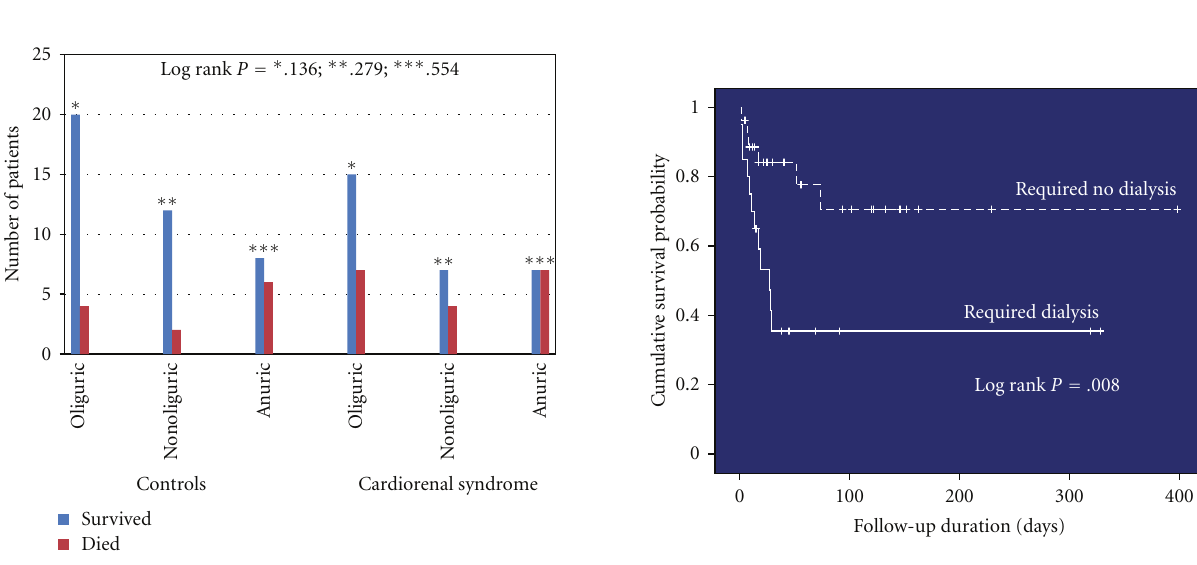
Figure 5: Kaplan-Meier survival curves for dialysis-requiring and non-dialysis requiring cardiorenal syndrome patients. Dialysis- requiring-cardiorenal syndrome had significantly lower survival rate compared to those who required no dialysis (35.5% versus